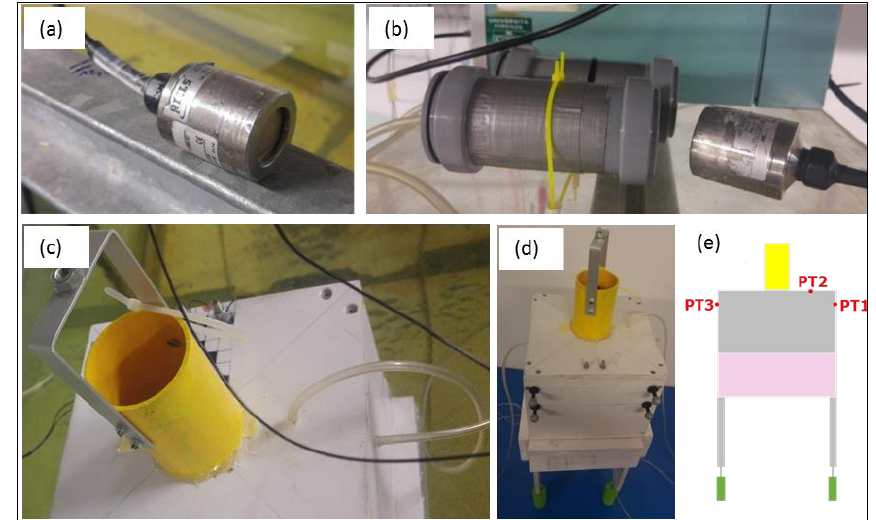
Figure 7. ( a ) Pressure transducers (PTs), ( b , c ) set-up of the pressure transducers on the floating OWC model ( b , c , d ), and ( e ) sketch of the PTs position on the OWC and pressure transducers ’ (PTs) naming.